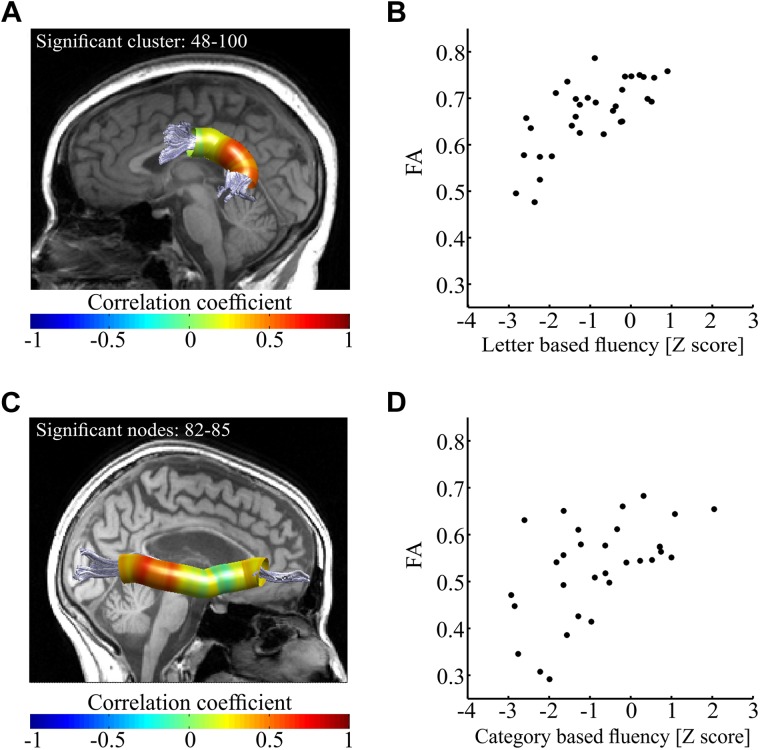
Correlations between fluency components and FA along the tract. (A,B) Correlations between letter-based fluency and FA along the left AFft. Panel (A) shows the left AFft in a single participant. Colored overlay represents Pearson’s r-values between letter-based fluency scores and FA values along the core of the tract (N = 32). Significant correlations were detected in a posterior cluster of 53 nodes (p < 0.05, FWE corrected for 800 comparisons, critical r = 0.599). In panel (B), mean FA of the significant cluster (nodes 48–100) is plotted against the letter-based fluency scores for each participant. This depiction is provided for visualization purposes only. (C,D) Correlations between category-based fluency and FA along the right IFOF. Panel (C) shows the right IFOF in a single participant. Colored overlay represents Pearson’s r-values between category-based fluency scores and FA values along the core of the tract (N = 31, 2 additional participants were excluded from analysis because we could not identify the R-IFOF in their data). Significant correlations were detected in a posterior cluster of four nodes (p < 0.05, FWE corrected for 800 comparisons, critical r = 0.611). In panel (B), mean FA of a window of 17 nodes around the most significant node (#83) is plotted against the category-based fluency scores for each participant. Here too, this depiction is provided for visualization purposes only. AFft, fronto-temporal arcuate fasciculus; IFOF, inferior fronto-occipital fasciculus.